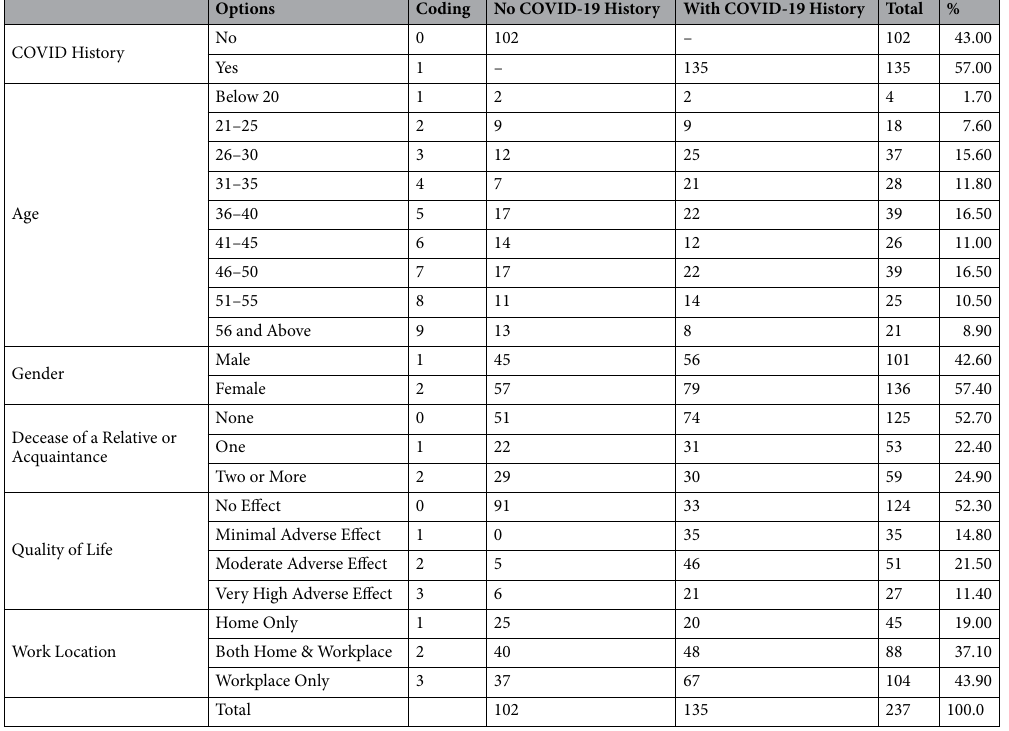
Table 1. Demographics of the